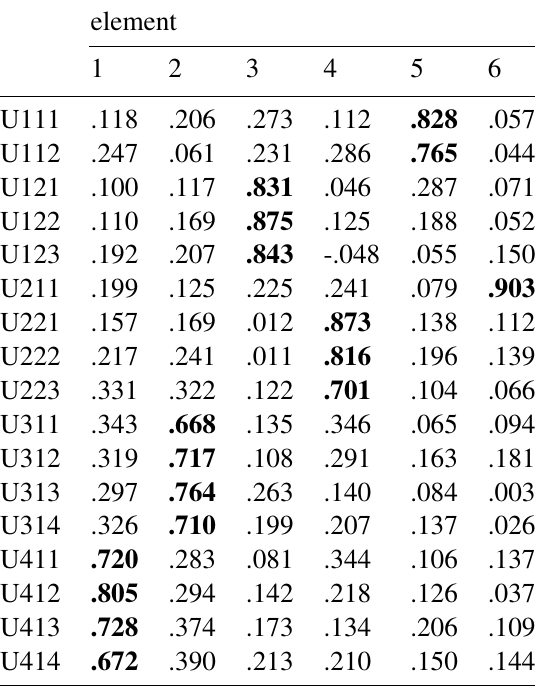
Table 2 Rotate element